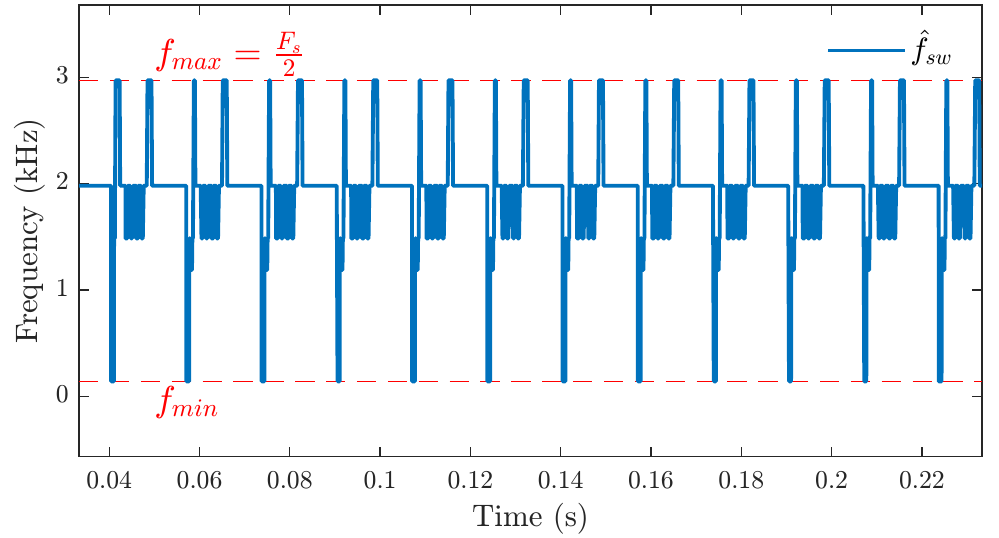
Figure 4. Instantaneous switching frequency FCS-MPC with the sampling frequency equal to 5940 Hz—calculated by Algorithm